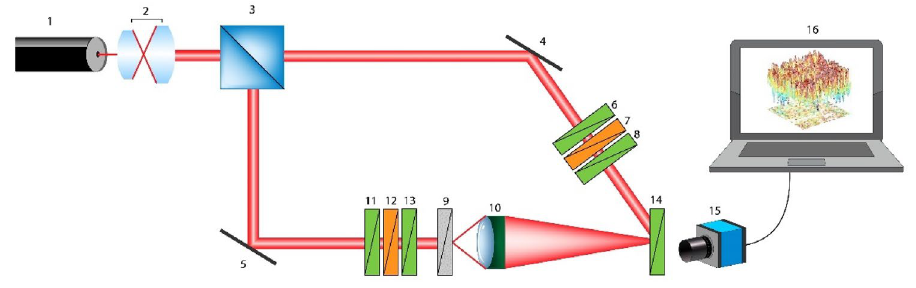
Figure 2. Optical scheme of 3D Mueller matrix polarimetry. Here: 1—laser; 2—collimator; 3—beam splitter; 4,5—reflecting mirrors; 6,8,11,13,14—polarisers; 7,12—quarter-wave phase plates; 9—object; 10—strain-free polarisation objective; 15—digital camera; 16—processing